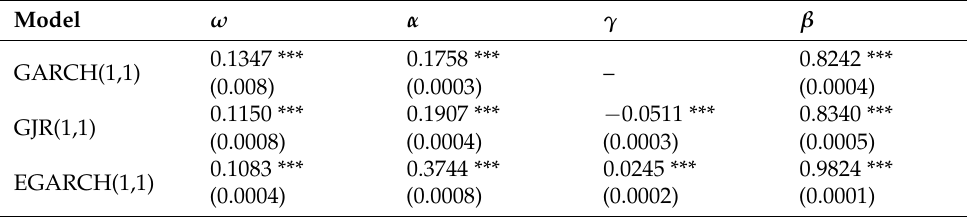
Table 2. Parameters estimates of the GARCH-type